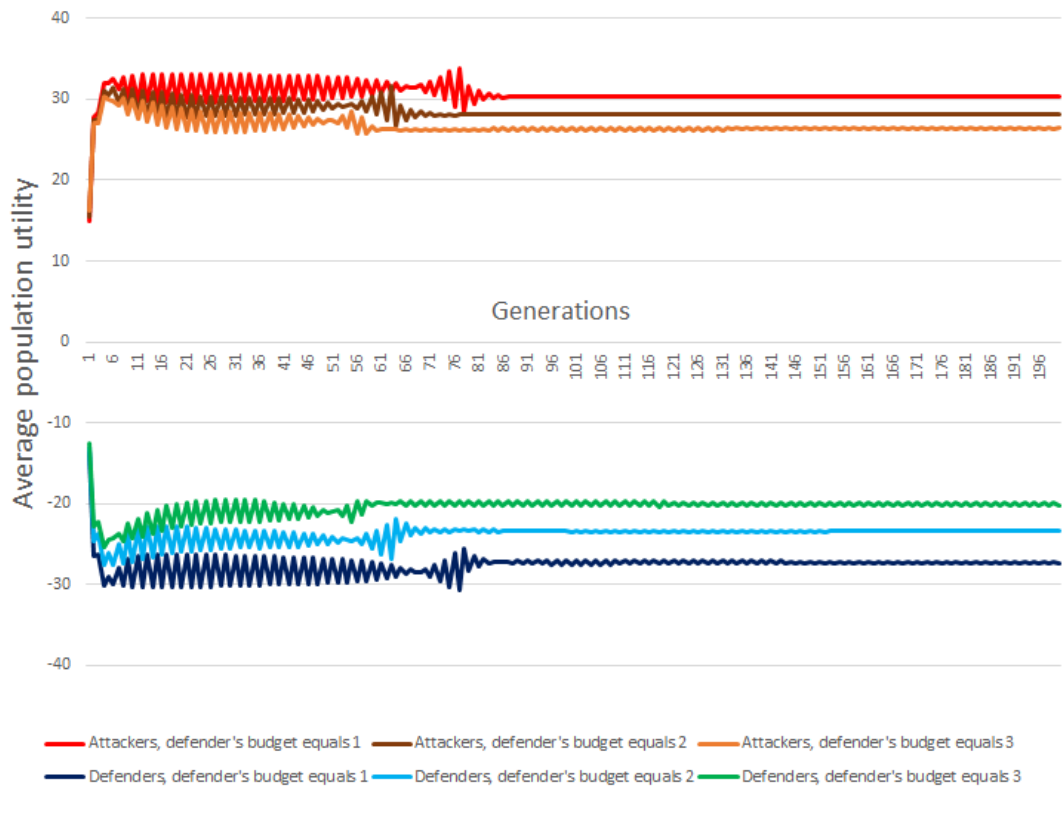
Figure 3. Evolution graphs for average utility for the attacker and defender populations for the case study. The results are shown for the defender’s budget equals to 1.0, 2.0, and 3.0. The x-axis presents the generations. The y-axis presents the evolution of average